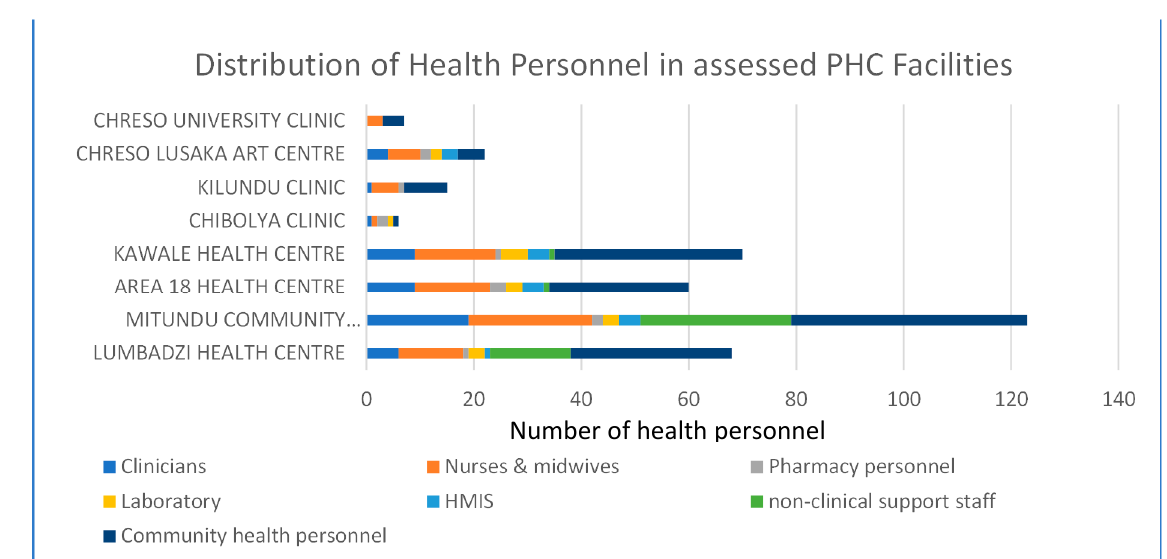
Figure 4. Distribution of health personnel in assessed PHC Facilities by cadre.